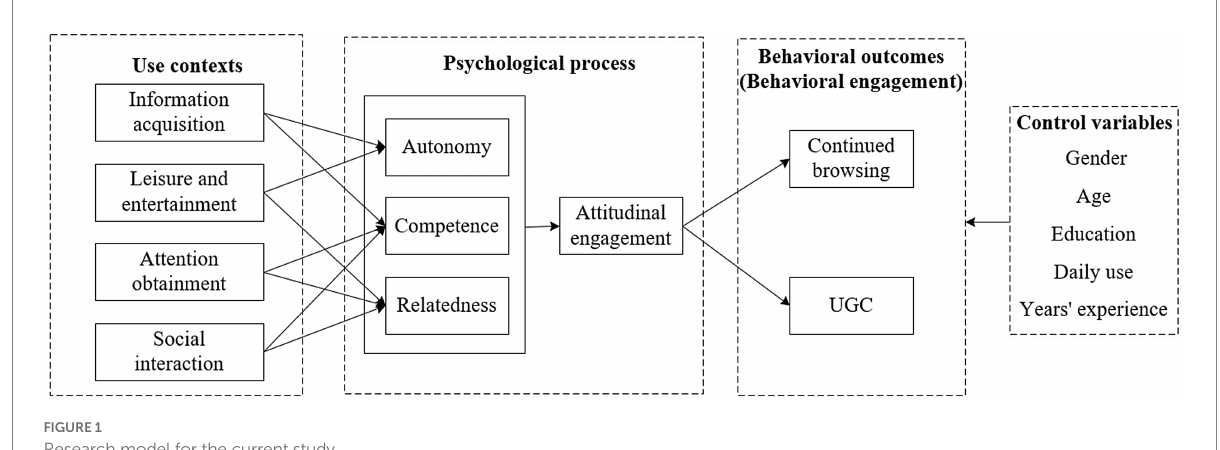
FIGURE 1 Research model for the current